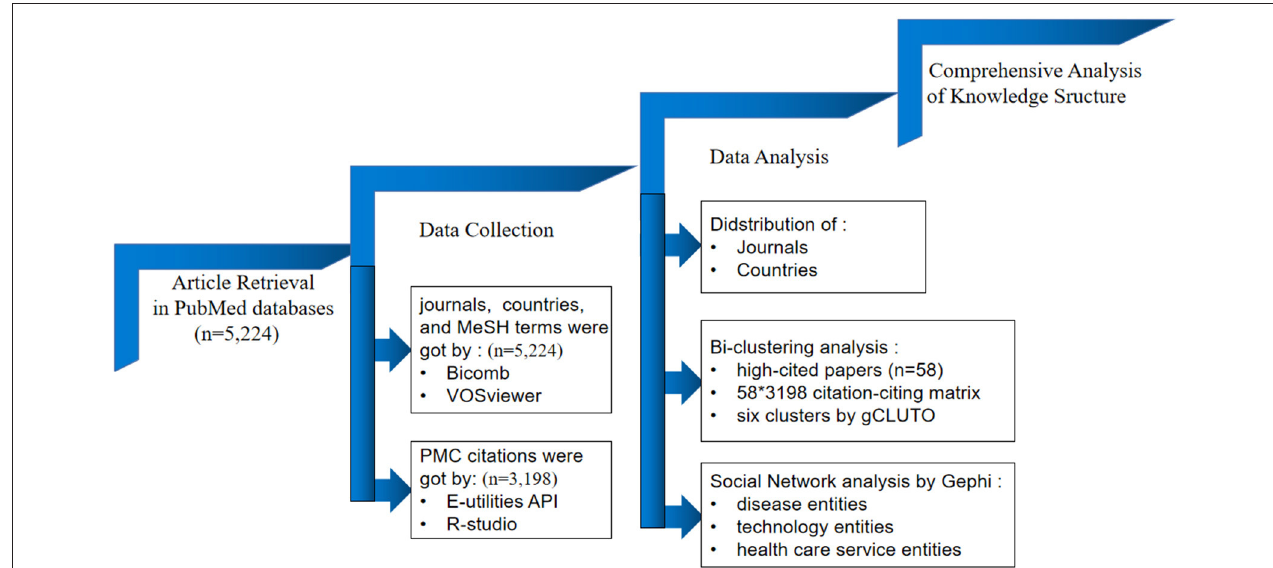
FIGURE 1 | Research design framework.